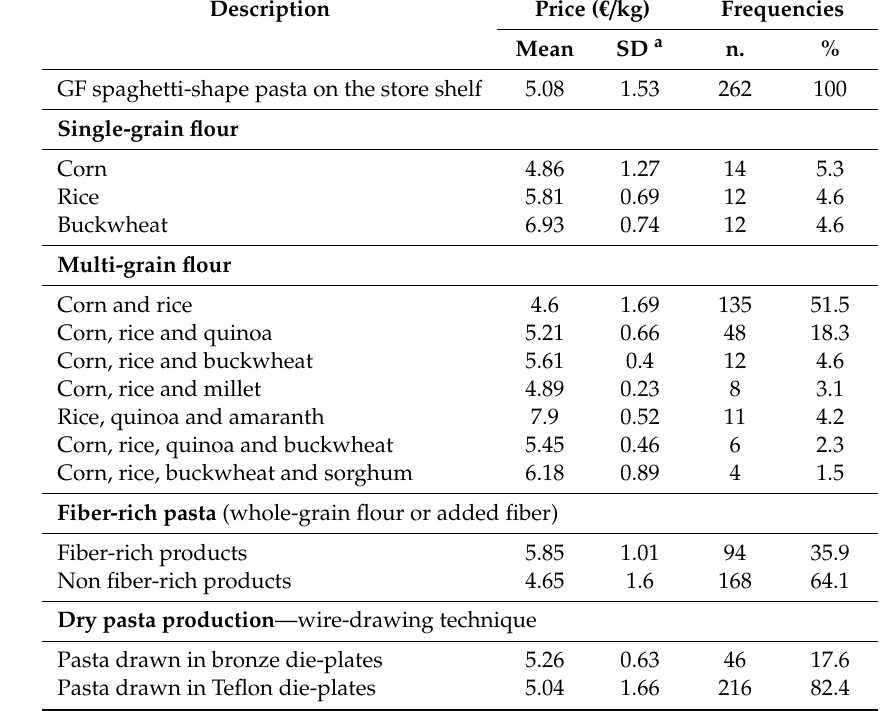
Table 2. GF selling units: product characteristics, prices and